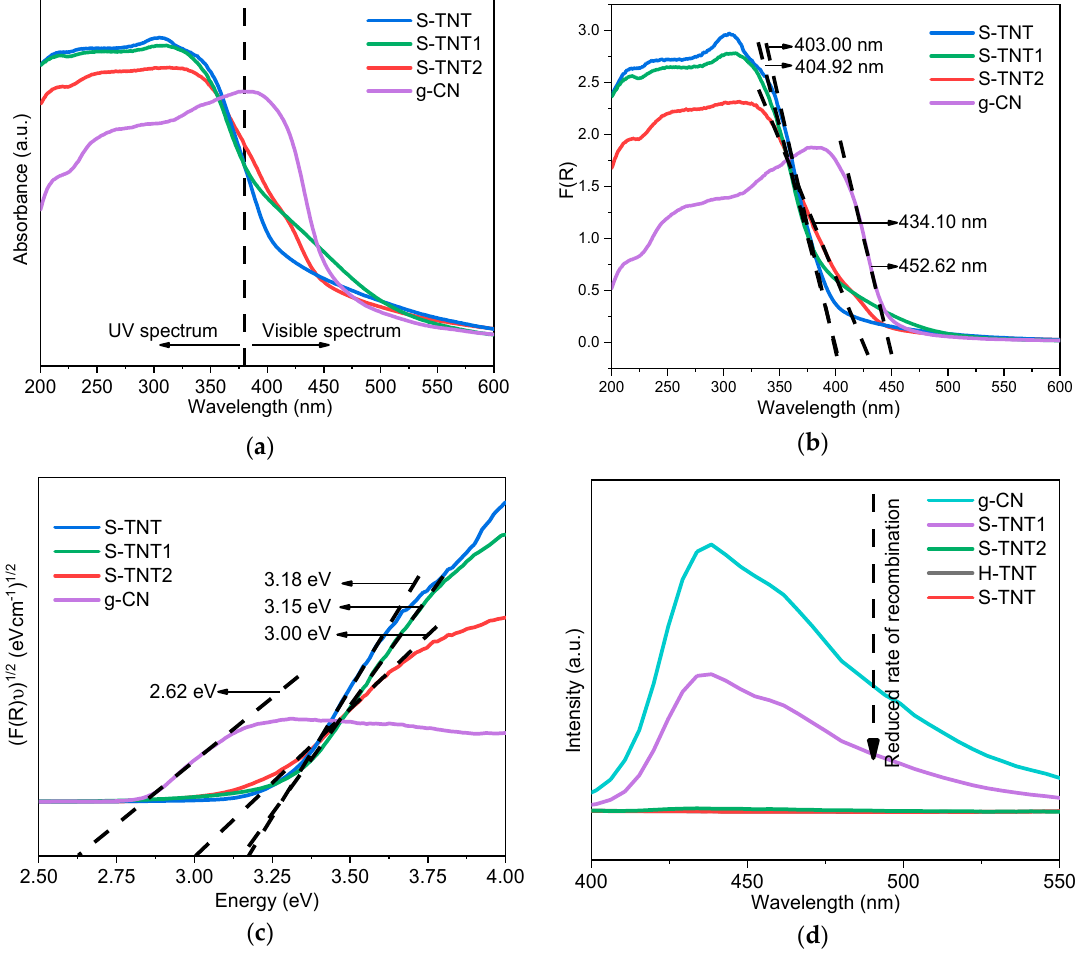
Figure 5. ( a ) UV/vis diffuse reflectance spectroscopy (DRS) (absorbance vs. wavelength), ( b ) UV/vis DRS (F(R) vs. wavelength), ( c ) converted Kubelka–Munk function vs. energy of absorbed light, and ( d ) photoluminescence (PL) spectra of the as-prepared S-TNT, S-TNT1, STNT2, and g-CN.